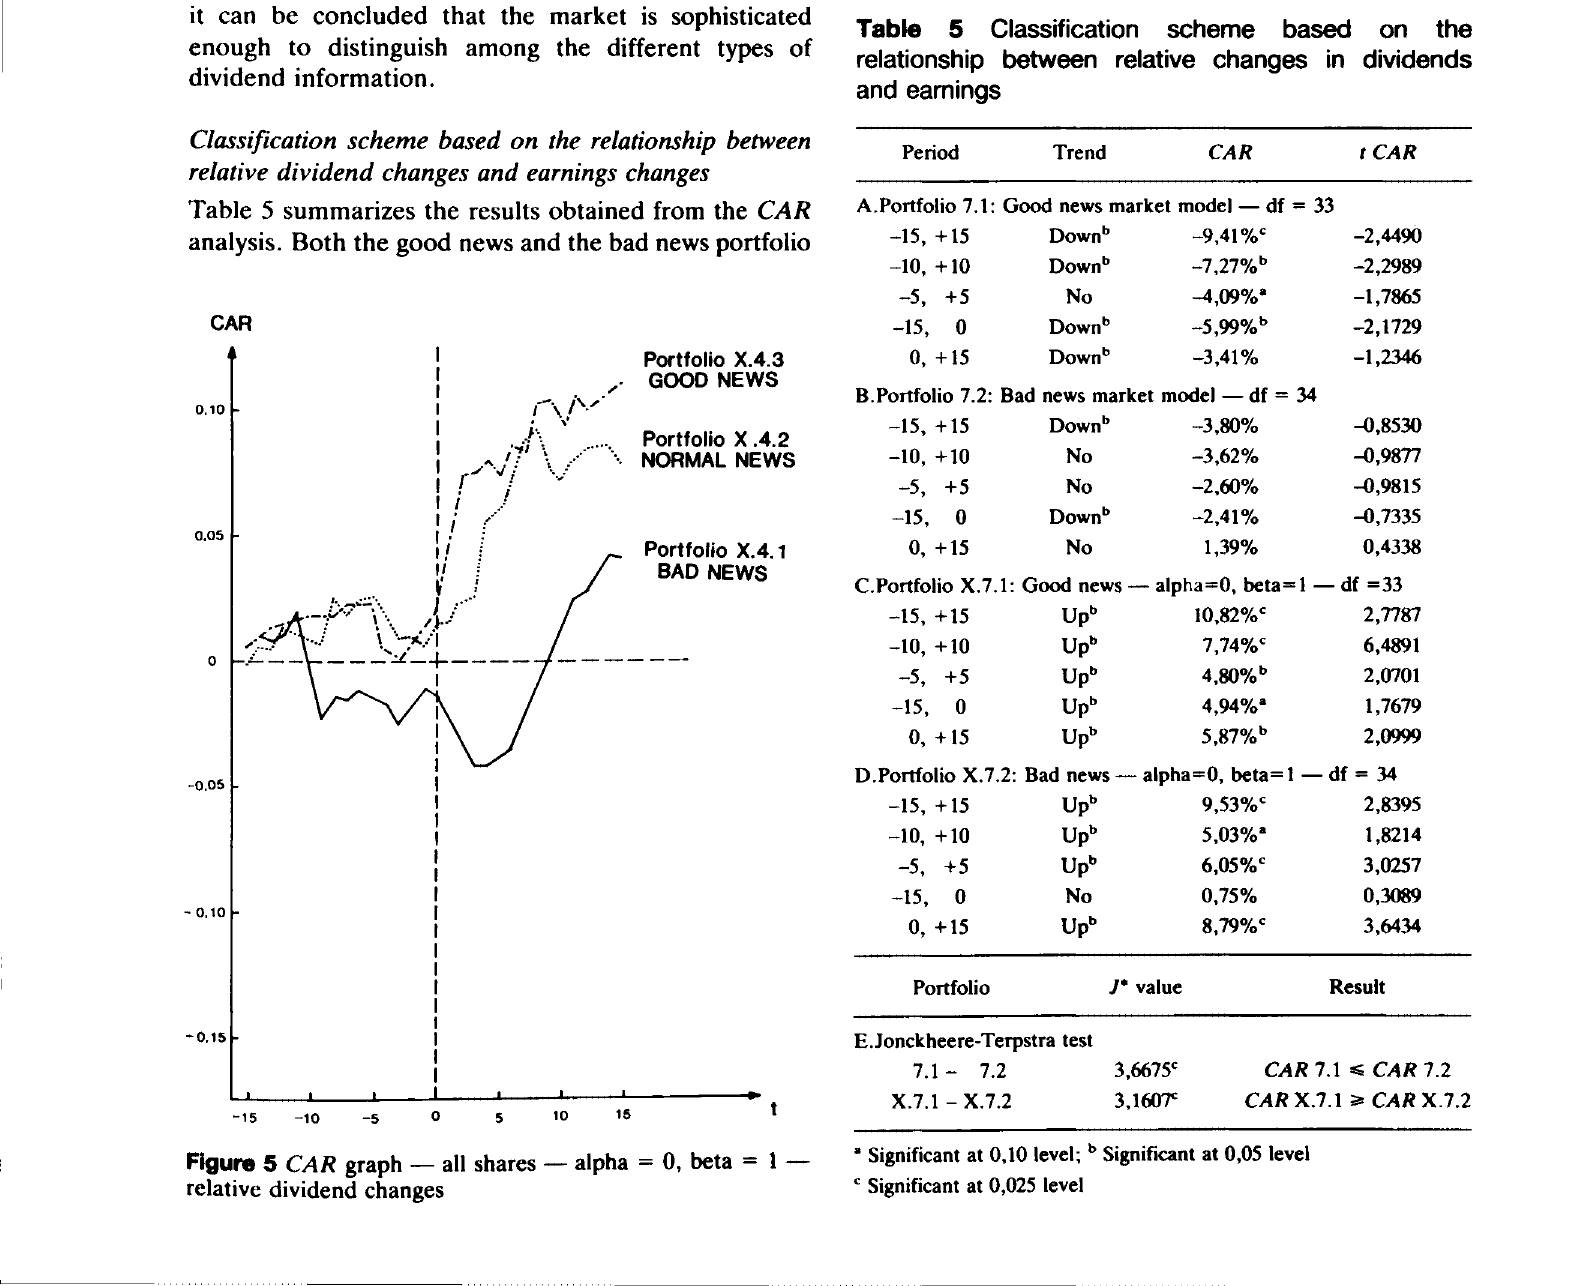
Figure 5 CAR graph - all shares - alpha = 0, beta = 1 - relative dividend